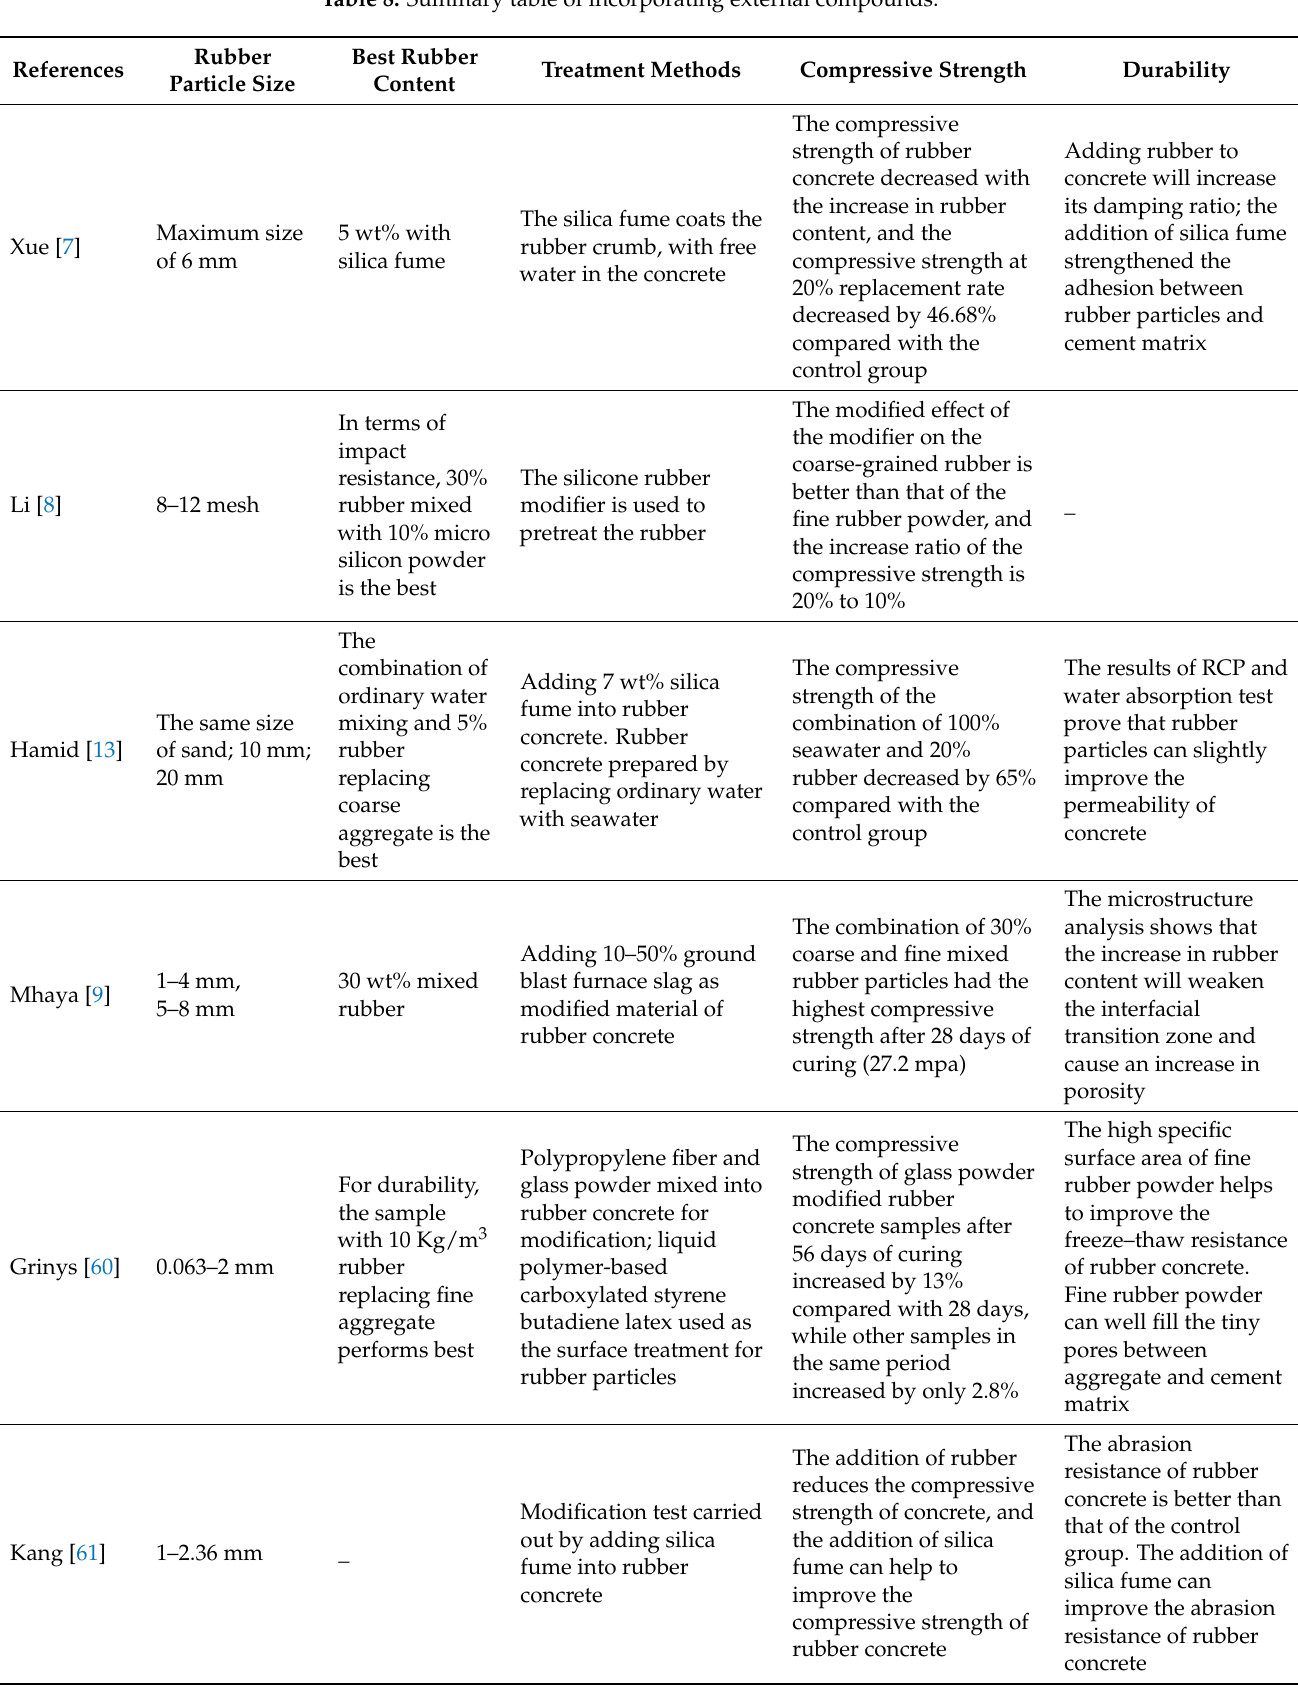
Table 8. Summary table of incorporating external